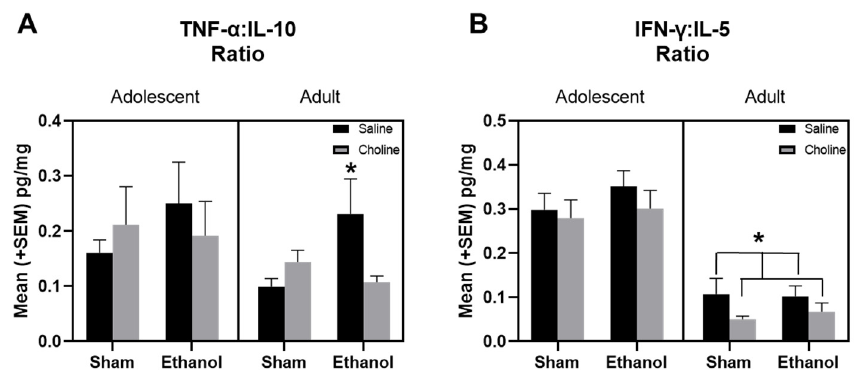
Figure 9. EtOH exposure and choline supplementation altered ratio of pro-inflammatory to anti- inflammatory cytokines. ( A ) Ratio of pro-inflammatory cytokine, TNF- α , to anti-inflammatory cytokine, IL-10 during adolescence and adulthood. EtOH exposure and choline supplementation altered the ratios of TNF- α :IL-10 in adults (EtOH + Saline > Sham + Saline, * p < 0.05), but not adolescents. ( B ) Ratio of pro-inflammatory cytokine, IFN- γ , to anti-inflammatory cytokine, IL-5 during adolescence and adulthood. Choline supplementation altered ratios of IFN- γ :IL-5 in adults (Choline < Saline, * p < 0.05) but not adolescents. n = 18–19 per group.